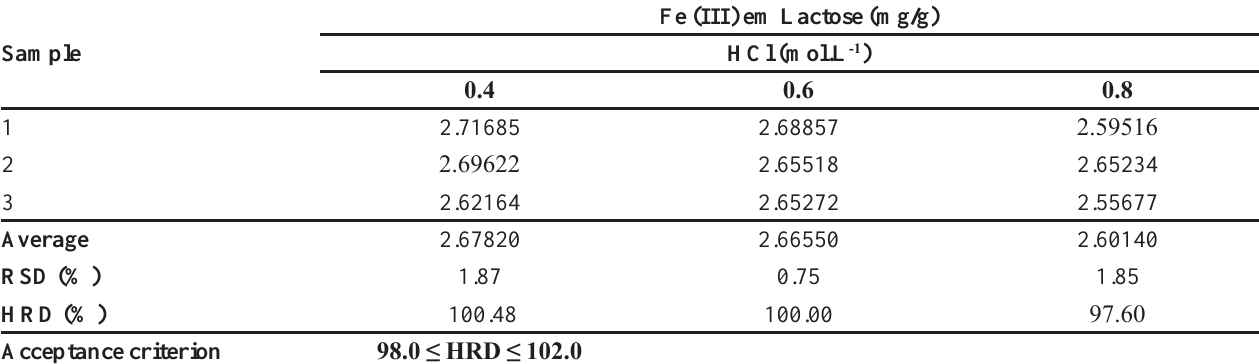
TABLE IX - Results of the robustness of the procedure in relation to the hydrochloric acid in the solvent solution ( l = 480 nm)